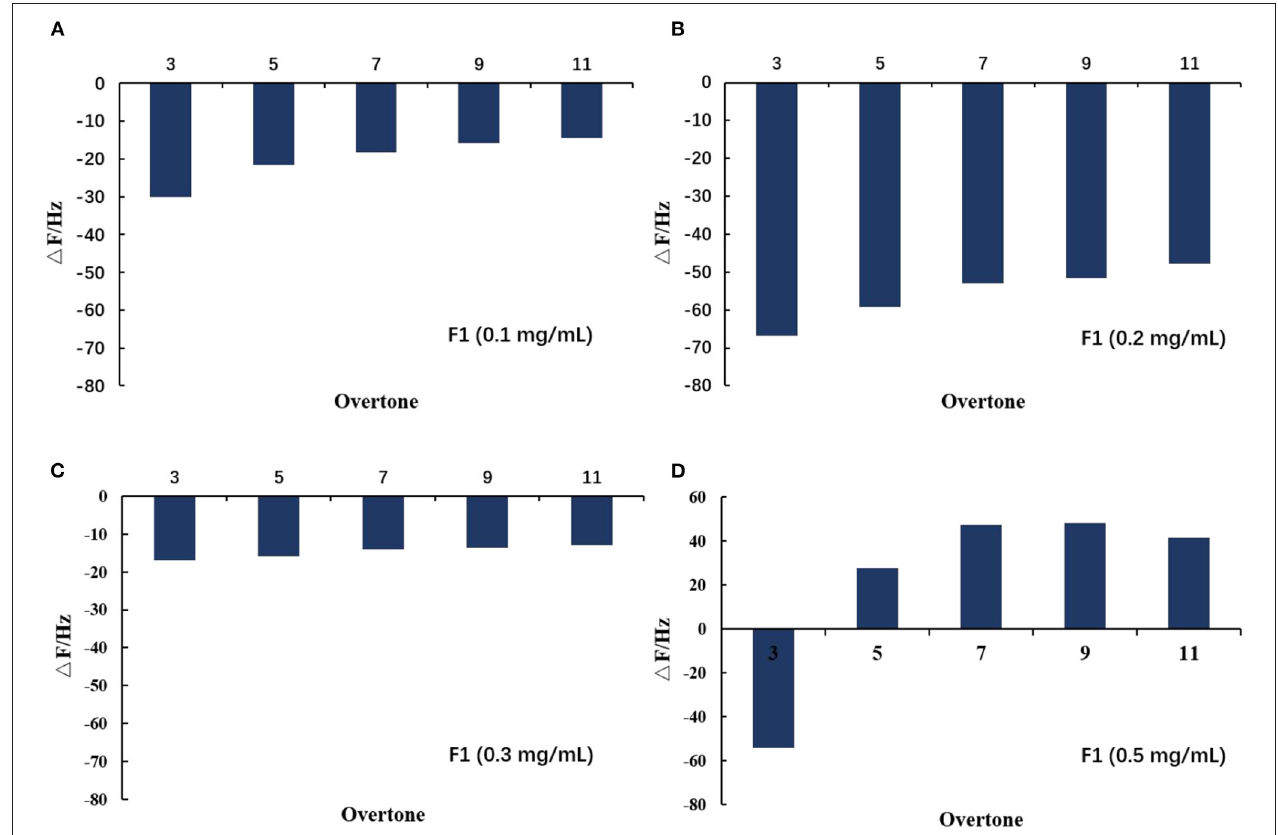
FIGURE 8 | Variation of film value on spreading phospholipid membrane at different octaves after applying antimicrobial peptide F1. Different concentrations of antimicrobial peptide F1: (A) 0.1 mg/mL, (B) 0.2 mg/mL, (C) 0.3 mg/mL, and (D) 0.5 mg/mL.